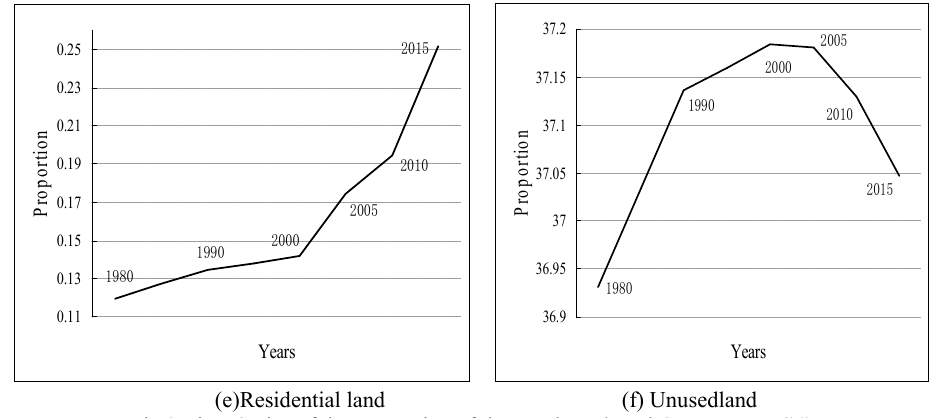
Fig.2 Time Series of the Proportion of the Land Use/Land Cover Types (%)